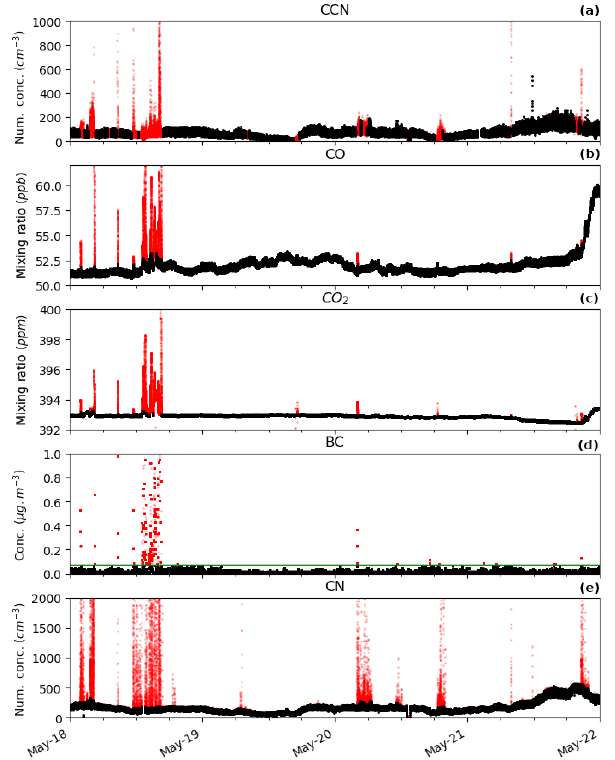
Figure 2. A 4d subset of the data from the 2016 voyage used to illustrate the algorithm, with filtered data (black) shown atop the raw data (red). Panel (a) shows the unfiltered CCN data along with data after the full filter is applied. Panels (b) to (e) show the filter parameters as both raw and with their individual filters applied. The green line in (d) represents the BC limit of 0.07µgm − 3 utilised. All data are raw instrument output without calibrations to aid in rapid dissemination of the exhaust identification product. Timestamps are UTC. Note that y axes are limited in range to reveal baseline val- ues (full data shown in Figs. A2 and A3). Exhaust signal for CO, CO 2 , BC and CN extends up to 800ppb, 490ppm, 10µgm − 3 and 10 6 cm − 3 ,